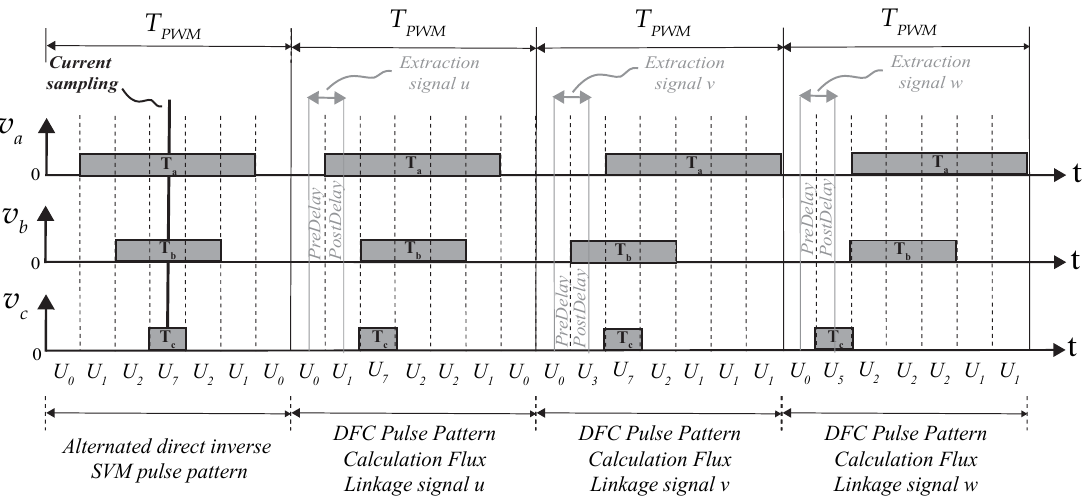
Figure 5. Inverter states for flux linkage measurement within the enhanced measurement sequence (SVM combinated with